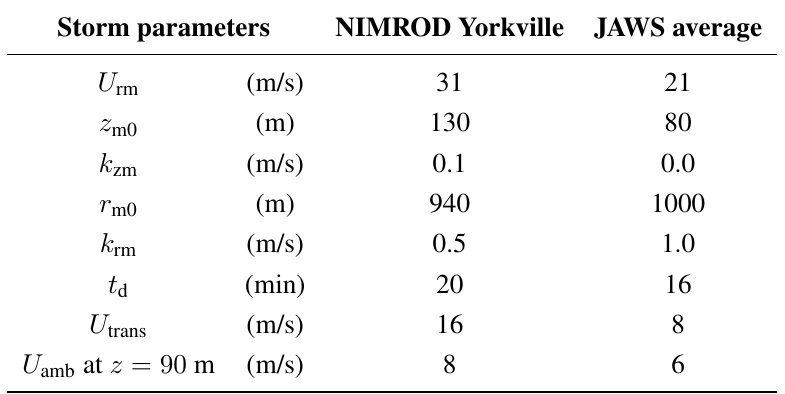
Table 2. Thunderstorm downburst parameters used in the simulations. NIMROD: Northern Illinois Meteorological Research on Downbursts. JAWS: Joint Airport Weather